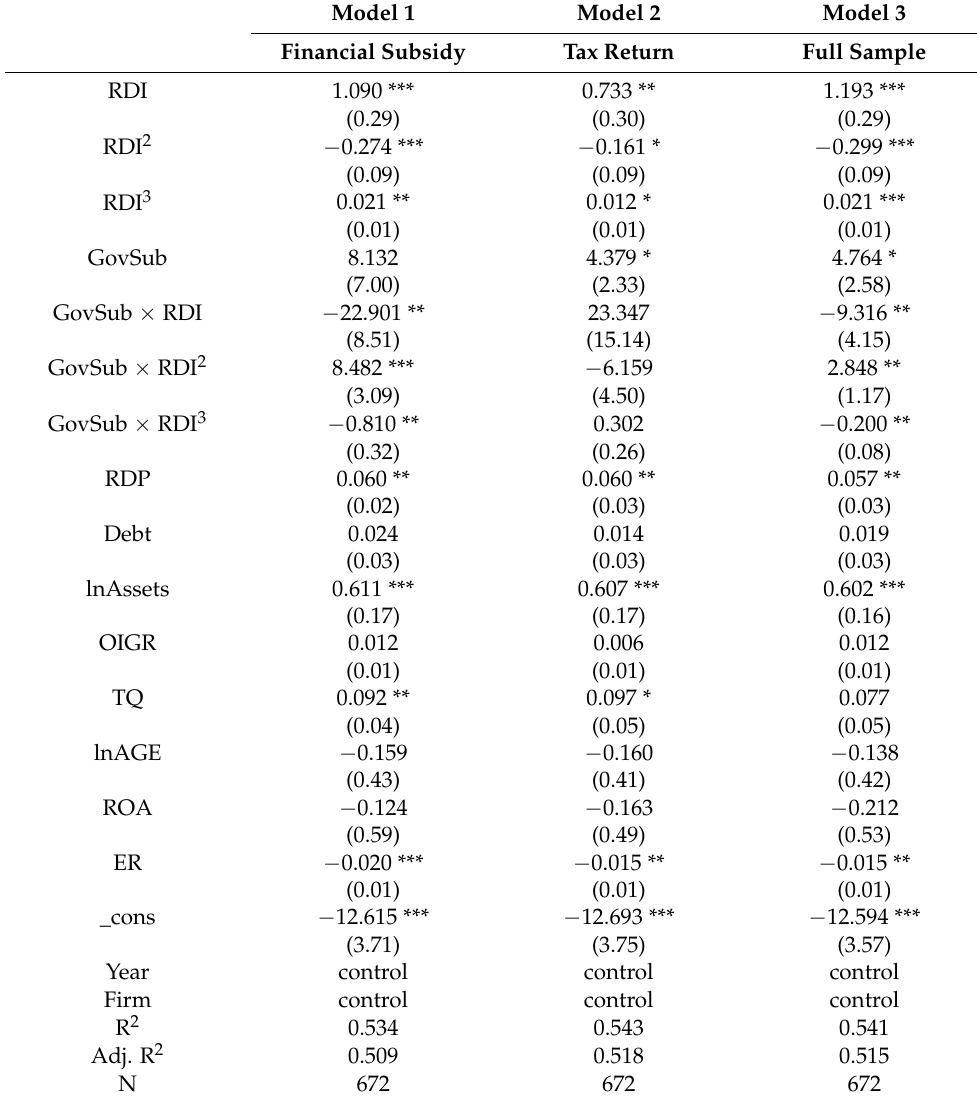
Table 7. Heterogeneity analysis of different government subsidy